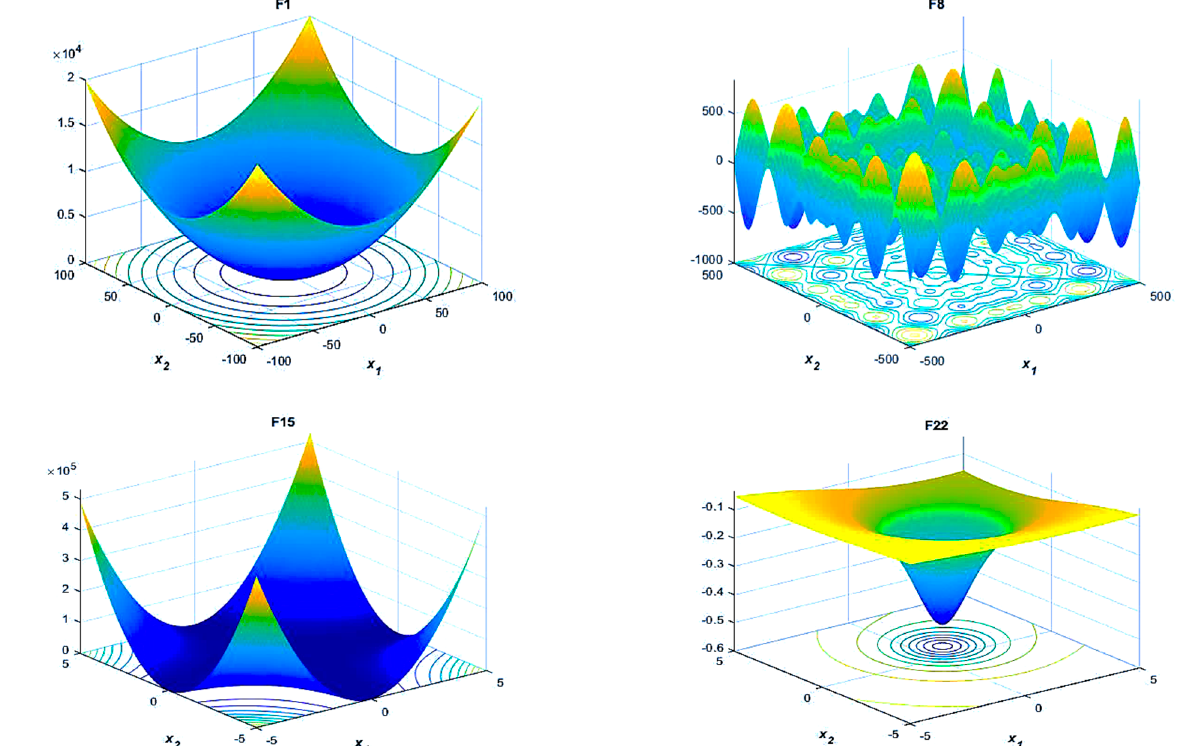
Figure 3. 2-D versions of the cost function for some benchmark problems. Table 2. Description of multimodal benchmark functions ( (cid:1832) (cid:2876) – (cid:1832) (cid:2869)(cid:2871) ).